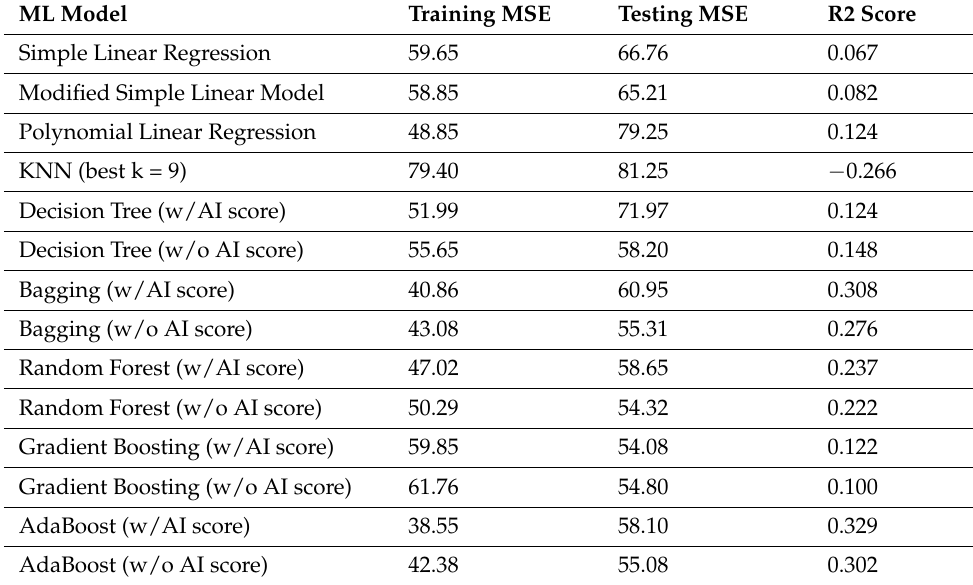
Table 2. Performance Comparison of the ML Models.